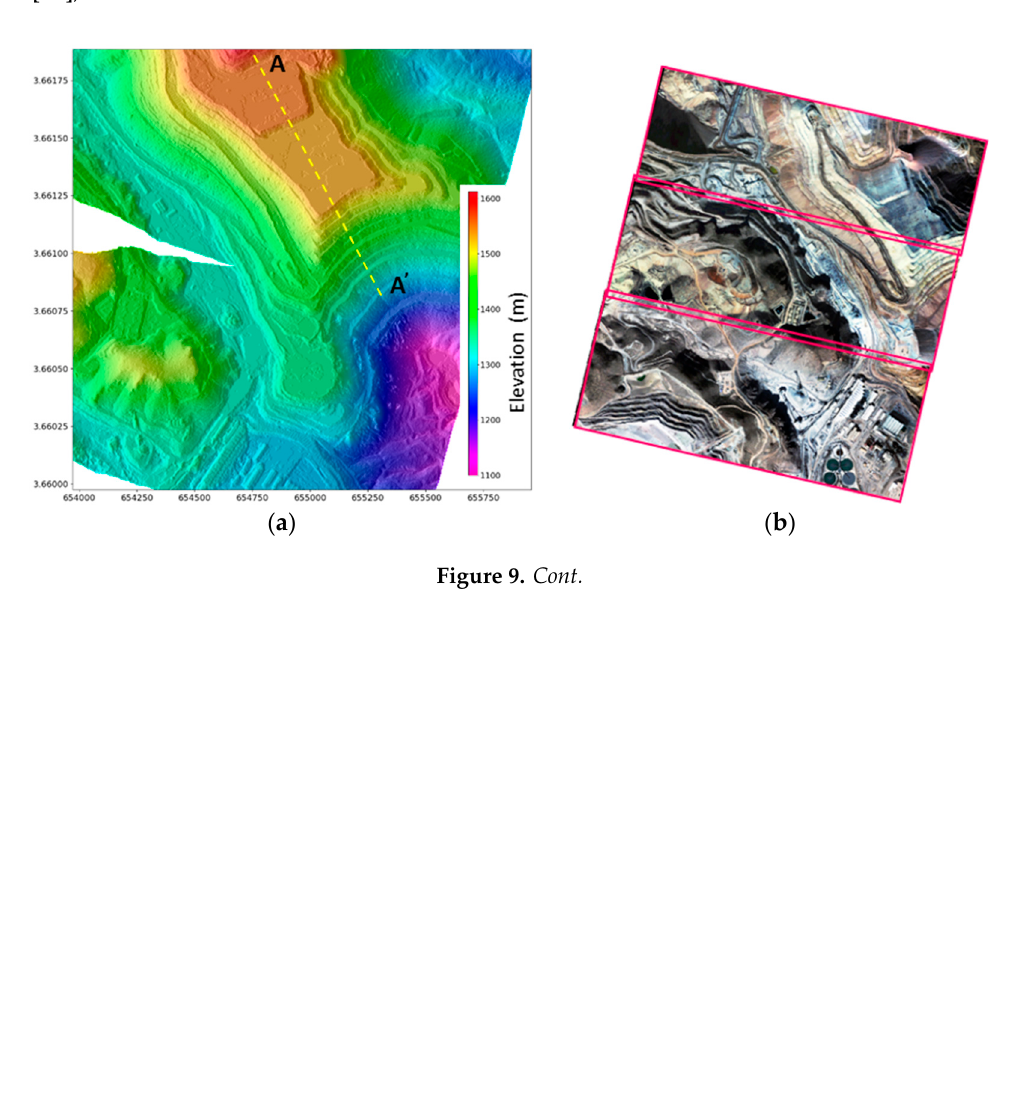
Figure 8. Subset of SkySat shaded DEMs over Morenci Mine using ( a ) backward and nadir images, ( b ) nadir and forwards images, ( c ) backward, nadir and forwards